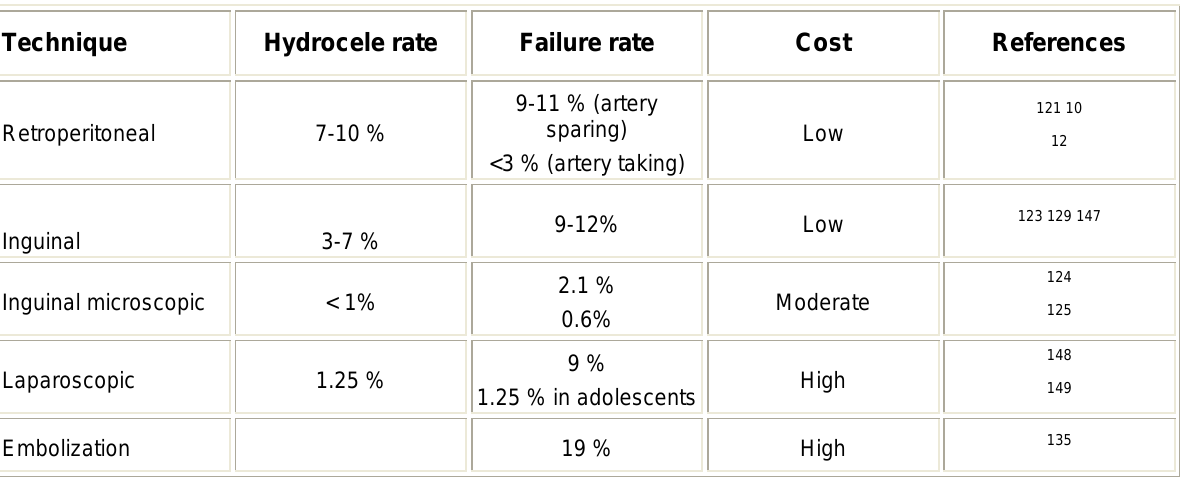
Surgical approach, complications and relative costs of varicocele